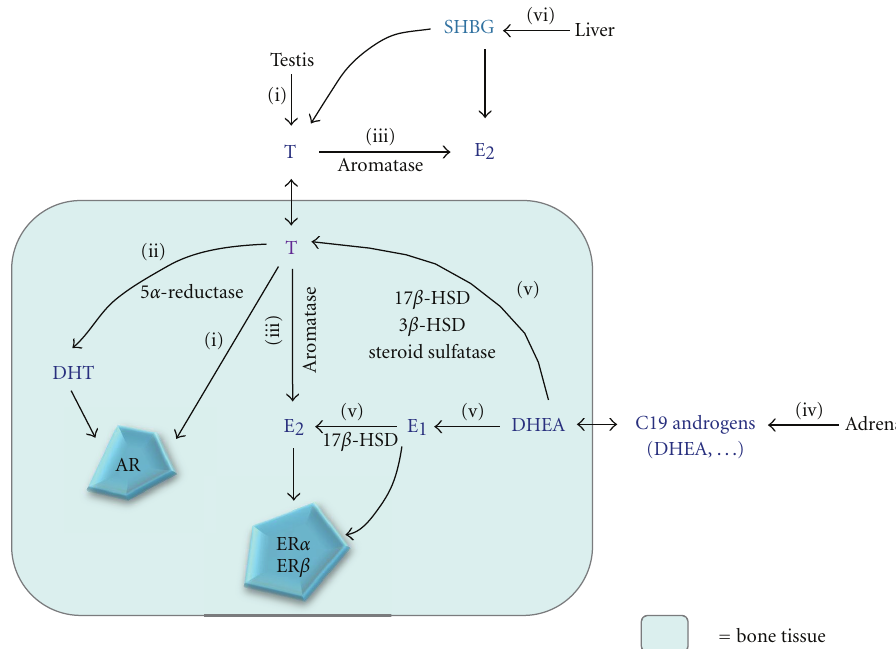
Figure 1: Metabolism of sex steroids. (i) Testosterone (T), that is secreted by the testes, can directly act on its receptor, the androgen receptor (AR), present in bone cells. (ii) T can also be converted locally to dihydrotestosterone (DHT) by 5 α -reductase. (iii) In addition, T can undergo aromatization to 17 β -estradiol (E 2 ) by aromatase. E 2 acts on one or both estrogen receptors (ER α or ER β ). (iv) The adrenals secrete C19 androgens including dehydroepiandrosterone (DHEA) that can also be converted to (v) estrone (E 1 ) and E 2 by aromatase, 17 β -hydroxysteroid dehydrogenase (17 β -HSD), and 3 β -HSD or to T by 17 β -HSD and/or 3 β -HSD. (vi) In men and women, T and E 2 are predominantly bound to sex hormone binding globulin (SHBG), synthesized by the